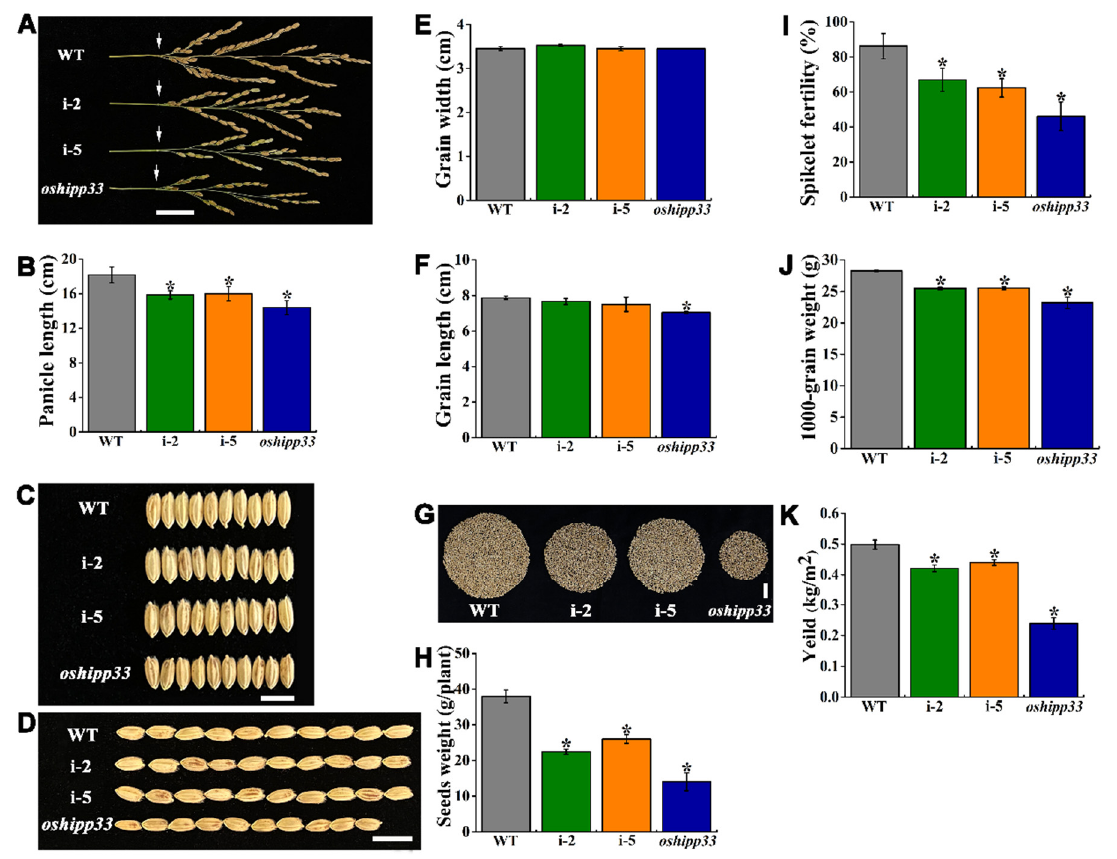
Figure 4. OsHIPP33 knockout ( OsHIPP33 mutant) and knockdown (RNAi, i-2 and i-5) lines developed the shortened panicle size and reduced grain yield. The rice varieties were grown in the field under natural conditions for two successive year trials. ( A ) Phenotypes of panicle (scale bars: 3 cm) and ( B ) panicle length. ( C – F ) Phenotypes of seed size (scale bars: 1 cm). ( G ) Total seeds collected (Scale bars: 3 cm) and ( H ) seed weight from one plant. ( I ) Spikelet fertility of one panicle and ( J ) 1000-grain weight. ( K ) Seed yield per square meter. The vertical bars indicate the means of biological triplicates and the asterisks show significant differences between the mutant lines and WT ( p < 0.05).